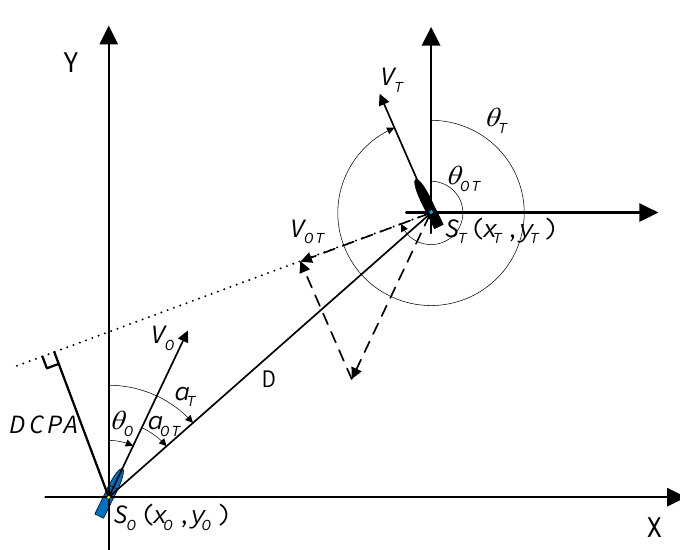
Figure 1. Motion parameters of two ships in a typical encounter situation.